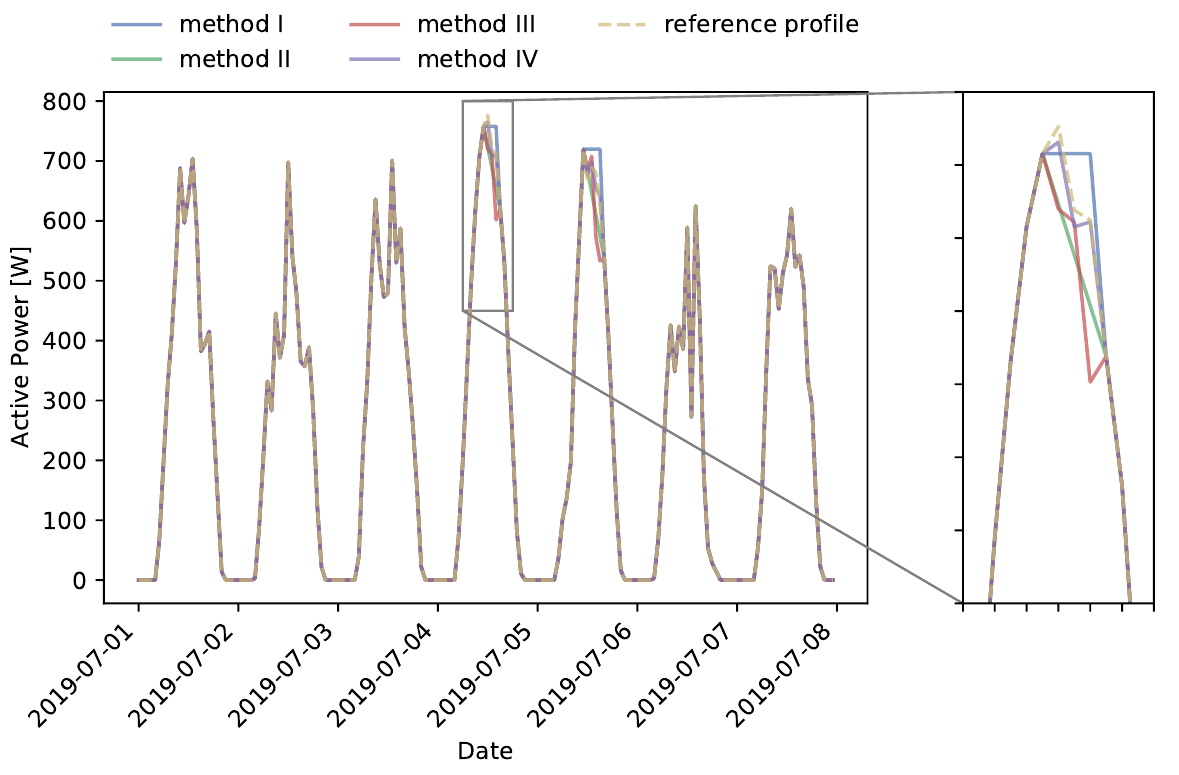
Figure 14. Comparing different baselining methods for curtailment option 2a.